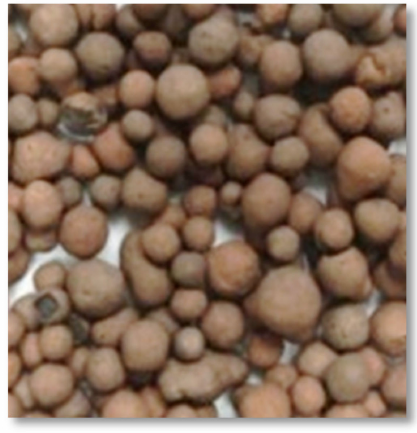
Figure 2. Expanded